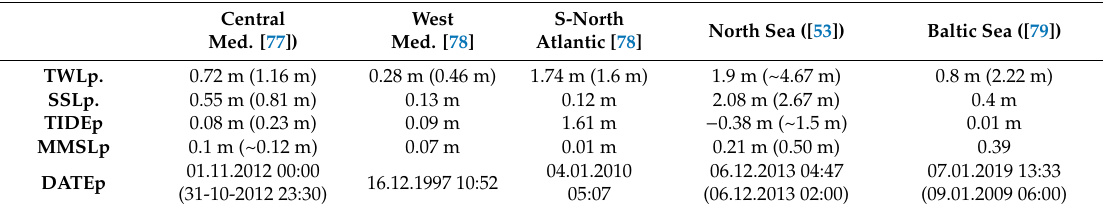
Table 4. Comparison of total water levels (TWLs) peaks captured by altimetry and measured from tide gauges. The data source providing the tide gauge information is indicated in